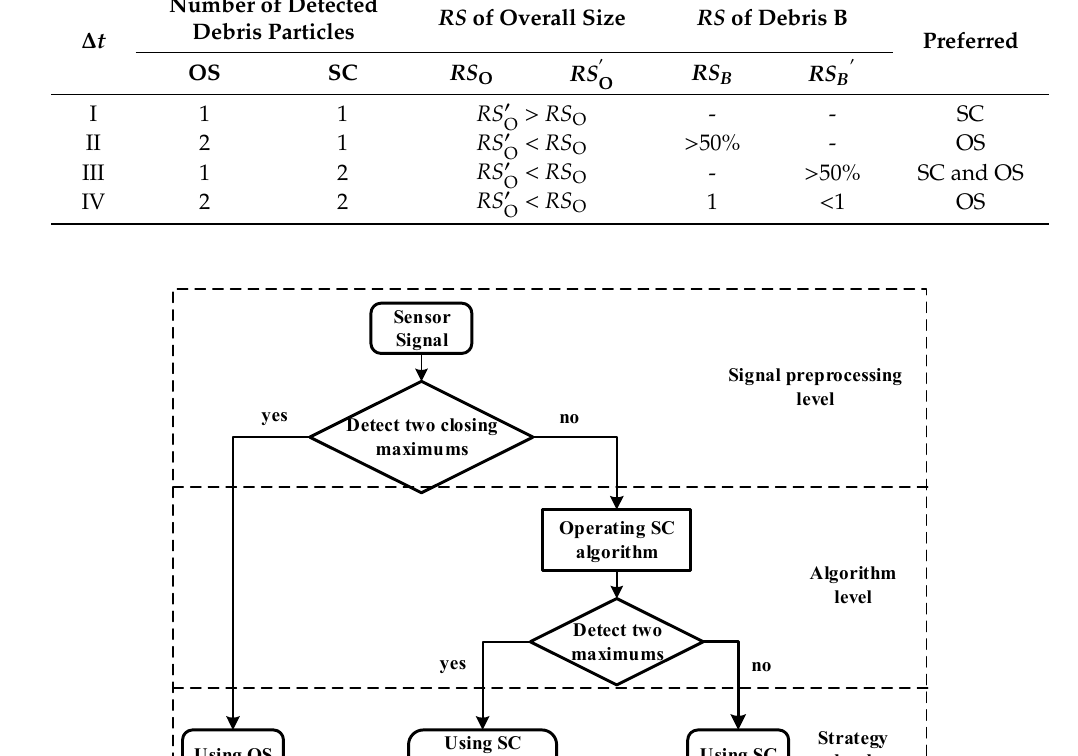
Table 4. Simulation